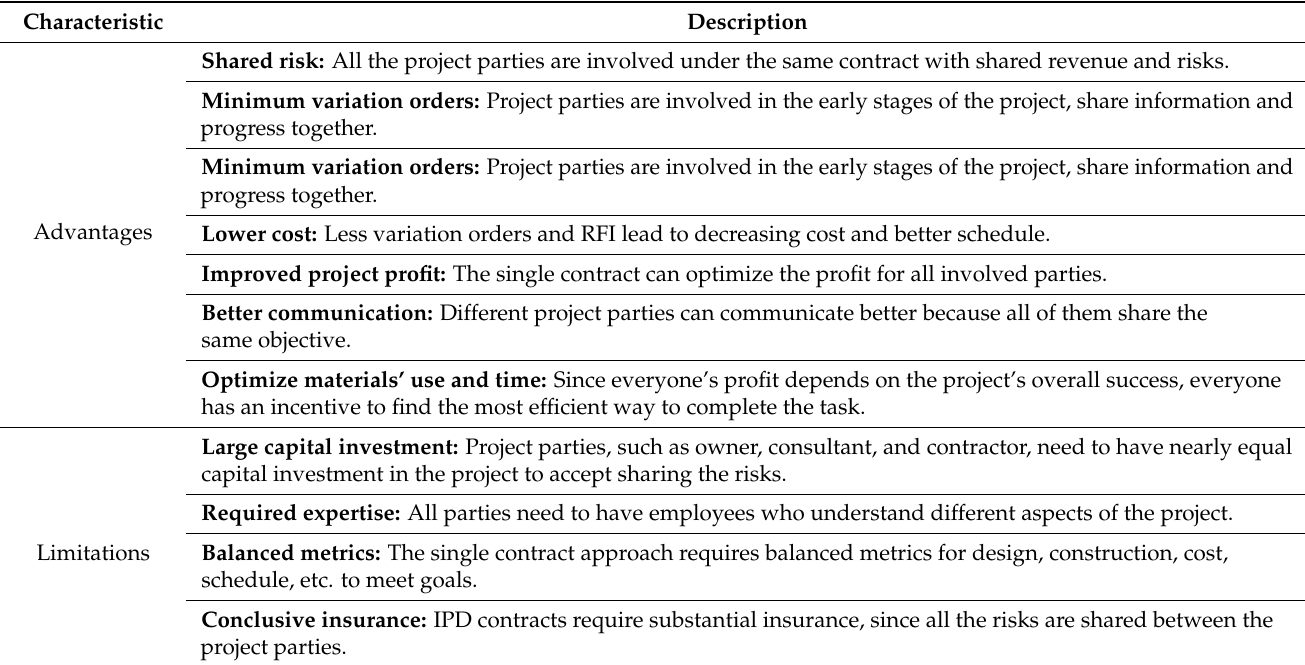
Table 2. Concise advantages and limitations of the IPD